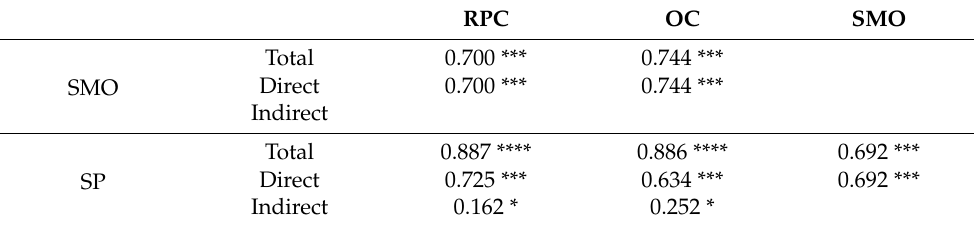
Table 10. Total, direct, and indirect effects among safety constructs in Hong